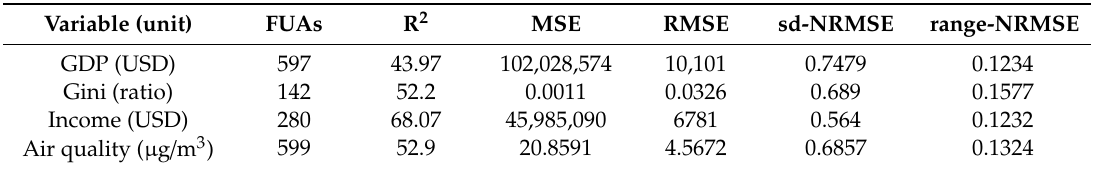
Table 2. Accuracy indices for mono-temporal models. GDP per capita, Gini, income and air quality regression models for 2014 using spatio-temporal metrics. FUAs represents the total number of FUAs in the model; R 2 , the coe ffi cient of determination; MSE, the mean square error; RMSE, the root mean square error in the same units as the variable; and sd-NRMSE and range-NRSME, the standard deviation and range-based normalized RMSE,